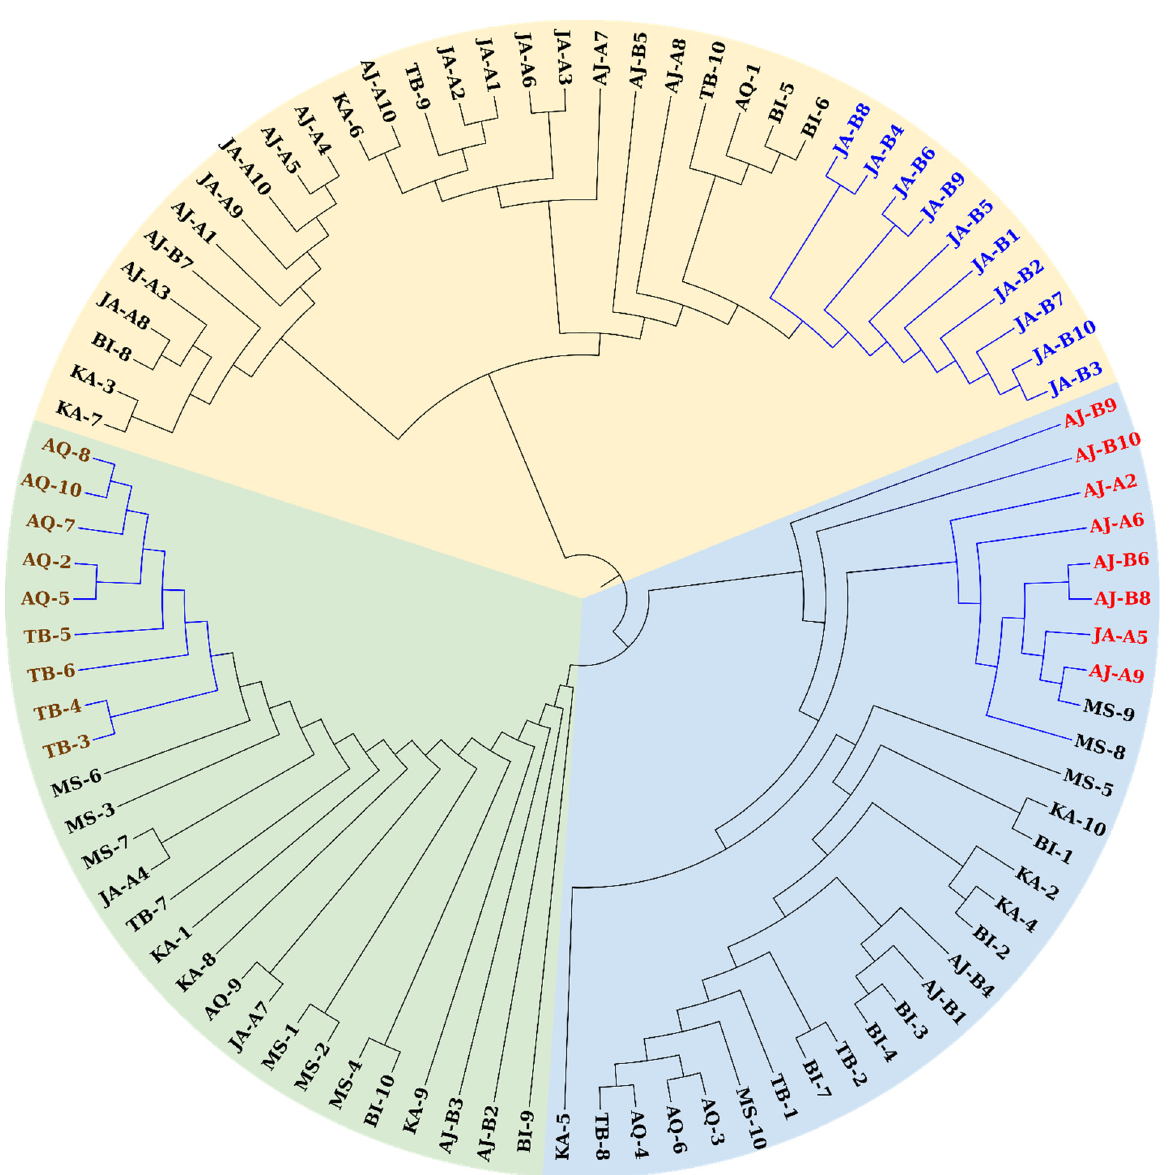
Figure 3. Phylogenetic tree constructed with RAxML software using AFLP marker data of 90 individuals of R. chalepensis collected from northern Jordan (BI: Beit Idis, MS: Massom, KA: Kofer Assad, Table 5. AMOVA for comparisons within and between R. chalepensis populations collected from northern Jordan. Sum of Mean Square Est. Var. Squares